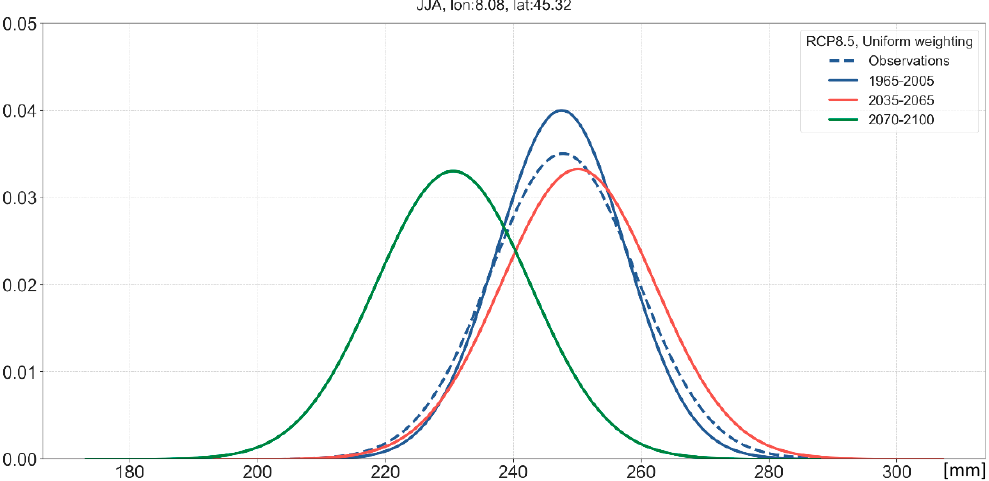
Figure 9. Probability density functions of observed and projected precipitation means (in mm) for a 1° × 1° reference cell centered in 8.08° E and 45.32° N, river Po basin, Northern Italy. Observations (blue dashed), post-processed control period (blue), prognostic window 2035–2065 (red) and 2070–2100 (green) projections, for the summer quarter June, July, August (JJA).